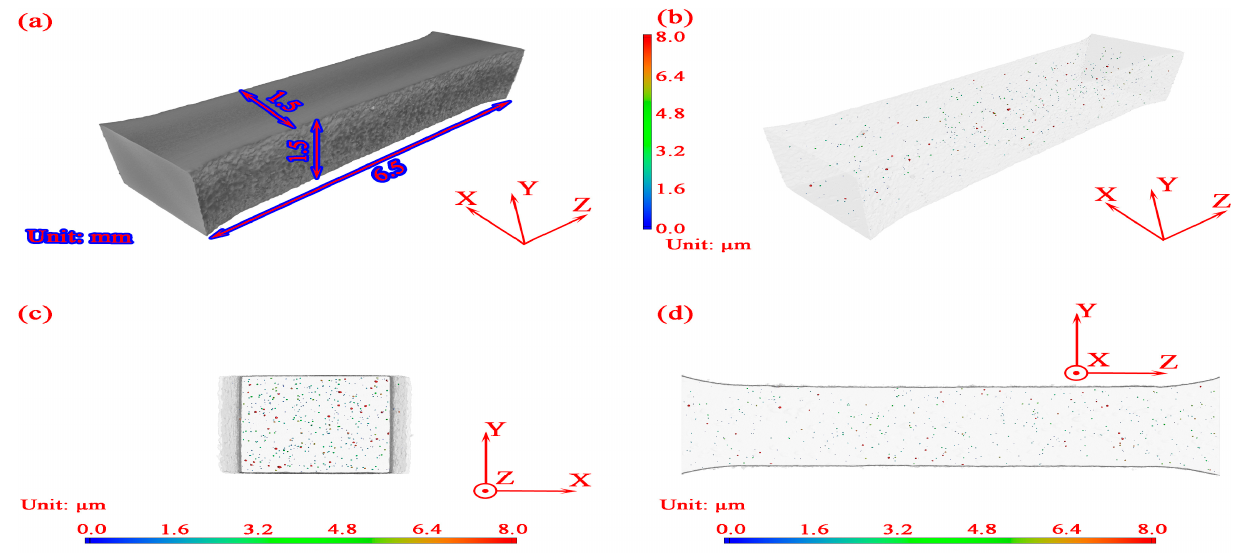
Figure 5. Three-dimensional reconstruction graphs showing the internal defect distribution within the M-VED NiTi sample: ( a ) selected scanning region, ( b ) axonometric drawing, ( c ) side view, ( d ) front view. Reprinted with permission from Ref. [84]. Copyright 2022, copyright Ge J, Yuan B, Zhao L.